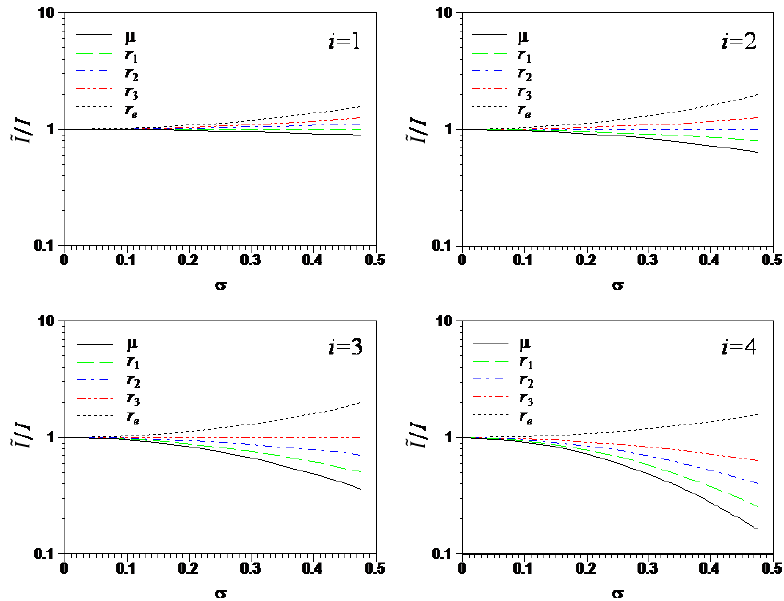
Figure 1: Ratios of different mean-size approximation (cid:1835)(cid:4634) Fig. 1. Ratios of different mean-size approximation ˜ I i to the true moment I i as a function of the size distribution width ( σ ) for various i values in Eq. size distribution spread (  ) for various i values in Eq. (10).